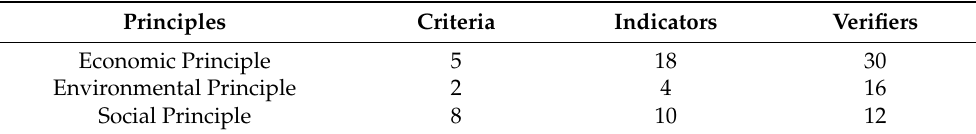
Table 1. Structure of the decision framework used in this study. Principles Criteria